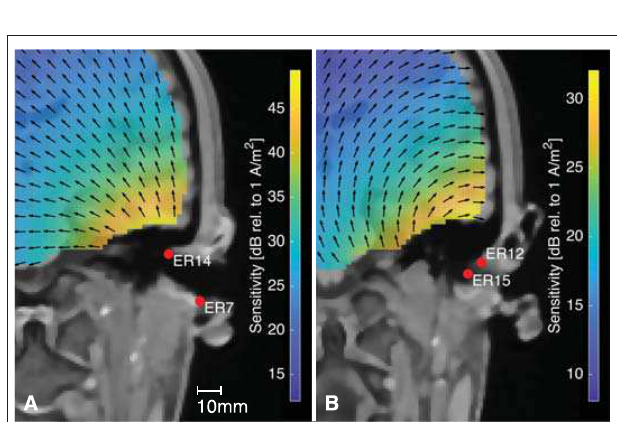
FIGURE 12 | The sensitivity distribution for two different within-ear electrode configurations, with the black arrows showing the orientation of the current density vector. (A) The ER14-ER7 electrode configuration, (B) The ER12-ER15 electrode